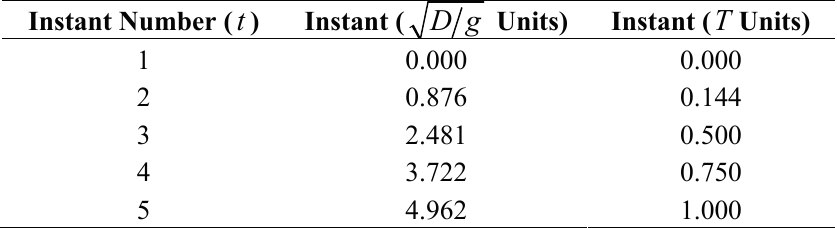
Table 5. Flow-field instants involved in the KL decomposition ( T is wave period).